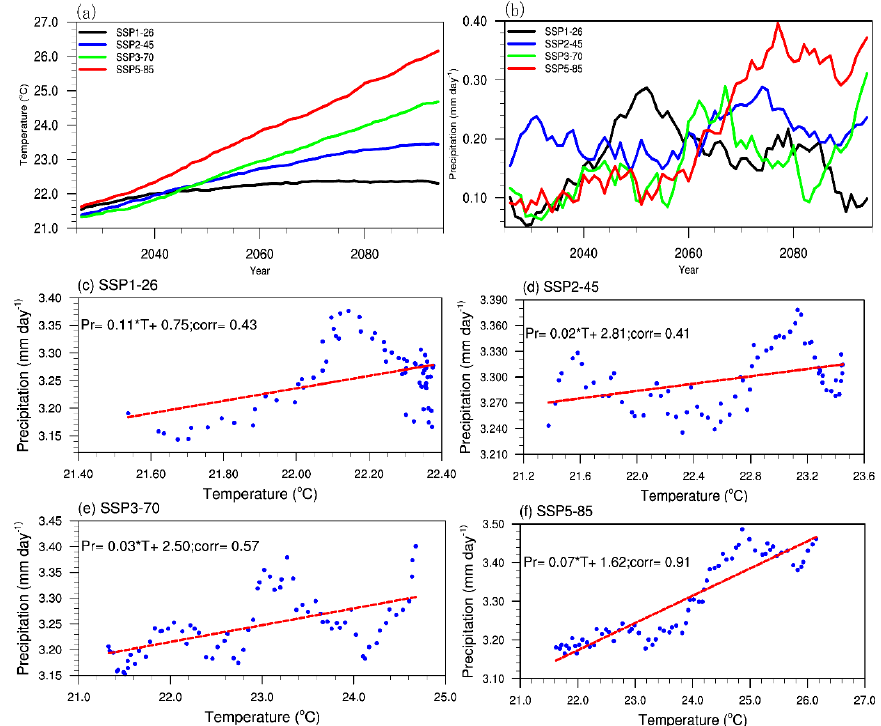
Figure 2. ( a ) Trend of the summer mean near-surface air temperature (unit: °C; 11 year running mean) over the YRB projected by the MMM of the selected CMIP6 models. ( b ) Future changes of summer precipitation (units: mm d −1 ; 11 year running mean) over the YRB projected by the MMM of the selected CMIP6 models relative to the historical mean. SSP1-2.6 (black), SSP2-4.5 (blue), SSP3-7.0 (green), and SSP5-8.5 (red). ( c – f ) The scatterplot with future near-surface air temperature (°C; 11-year running mean) on x, and future summer precipitation over the YRB (mm d −1 ; 11 year running mean) on y projected by the MMM of the selected CMIP6 models during the 21st century under ( c ) SSP1-2.6; ( d ) SSP2-4.5; ( e ) SSP3-7.0; and ( f ) SSP5-8.5.